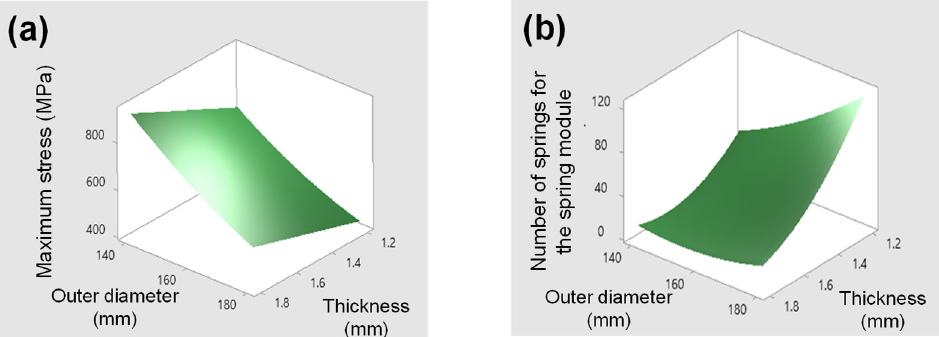
Figure 15. Surface plot of ( a ) maximum stress versus outer diameter and thickness and ( b ) number of springs for spring module versus outer diameter and thickness.